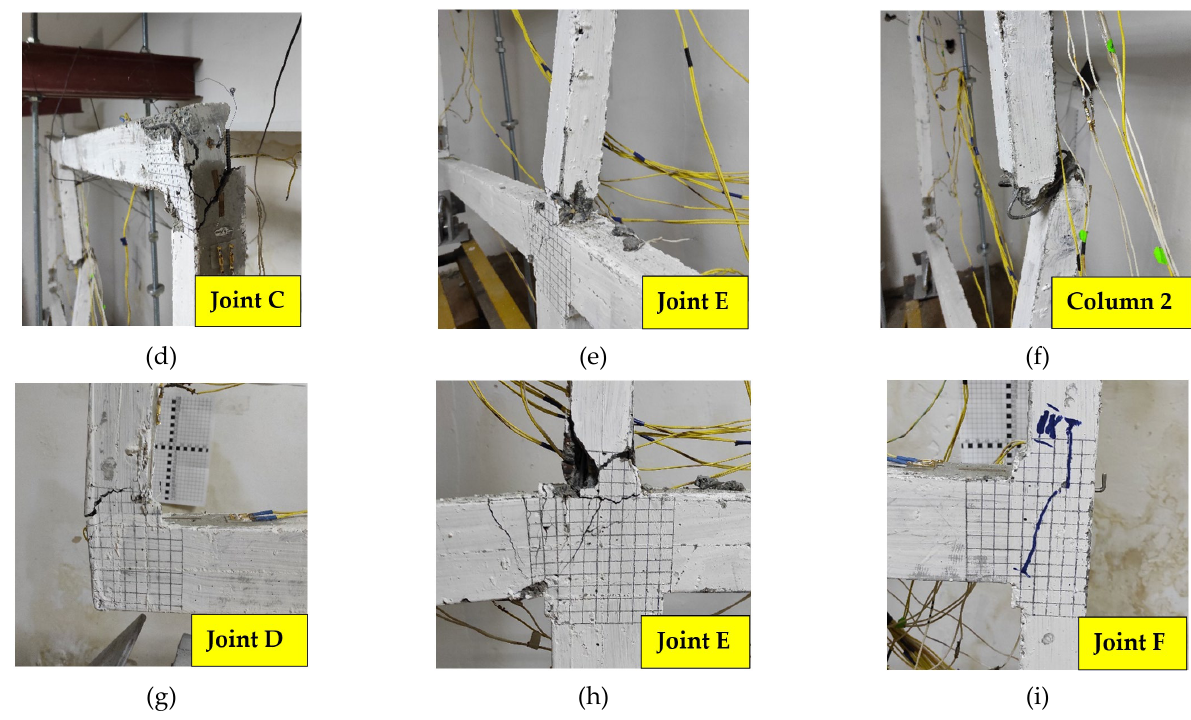
Figure 12. Test frame joints after an accidental impact: joint A front view ( a ), joint B front view ( b ), joint C front view ( c ), joint C side view ( d ), joint E side view ( e ), middle section of the column 2 ( f ), joint D front view ( g ), joint E front view ( h ), joint F front view ( i ),